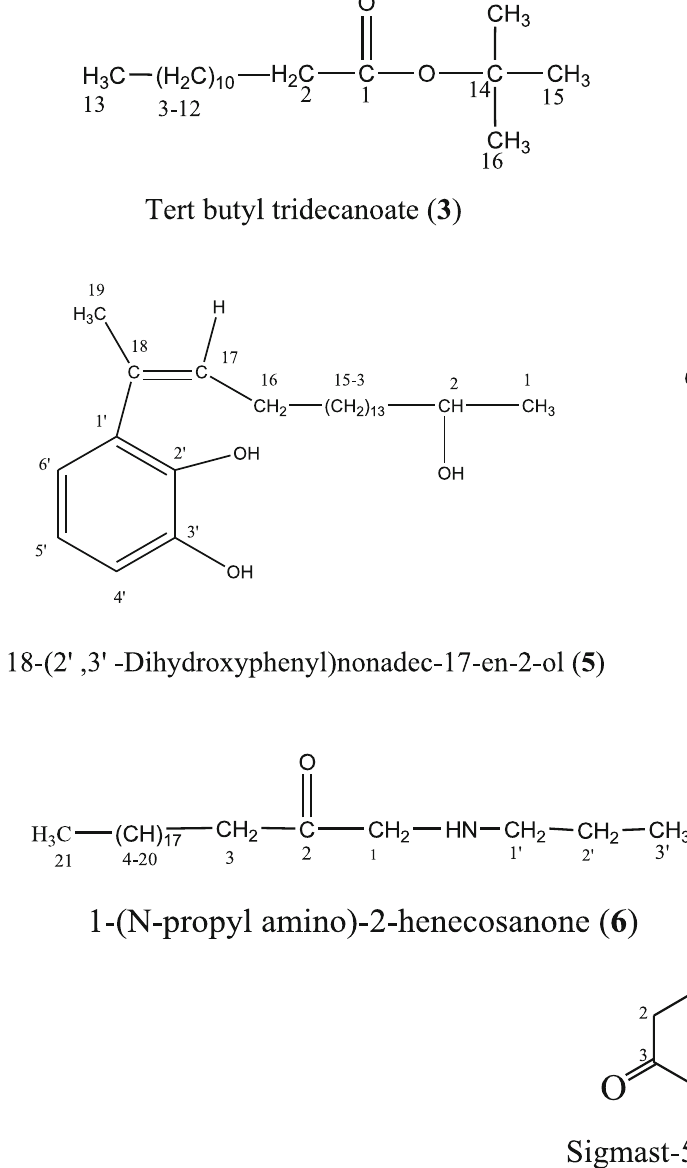
Fig. 1 Isolated compounds from the bark of Adenanthera pavonina